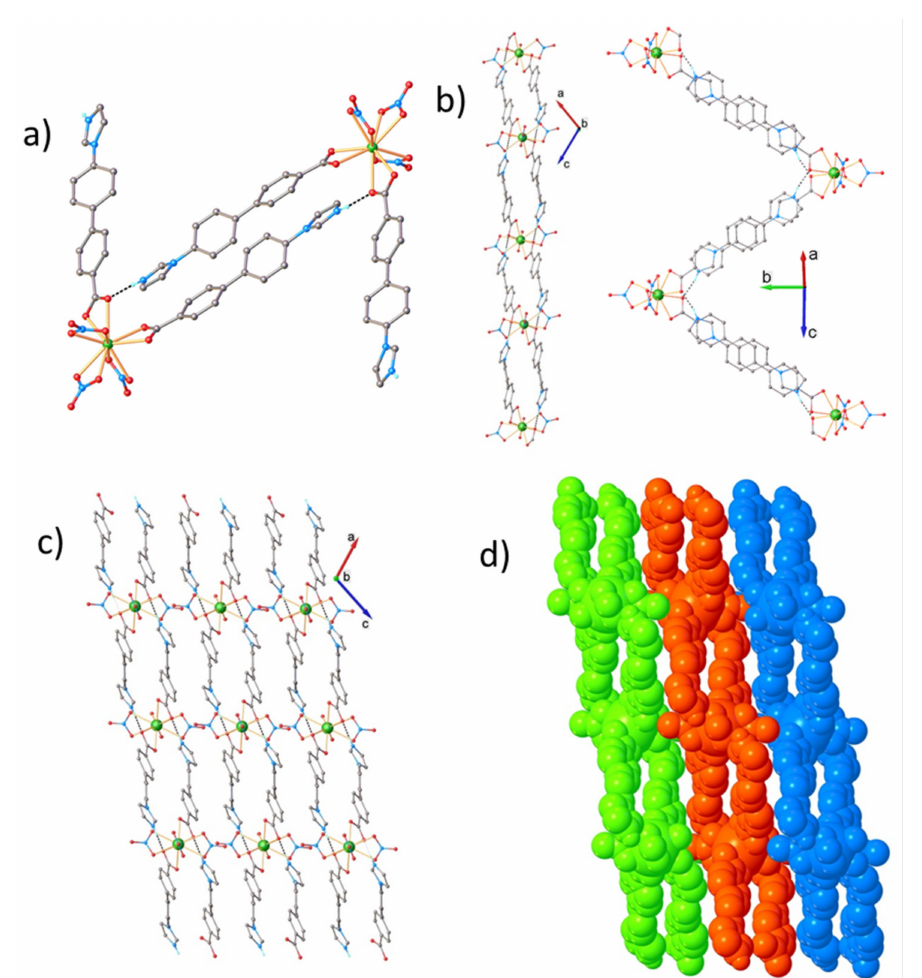
Figure 7. ( a ) The interaction of neutral [Eu(HL) 2 (NO 3 ) 3 ] complexes through N-H · · · O hydrogen bonds; ( b ) A view of zig-zag double chain along 010 and 101 directions; ( c ) Partial crystal packing viewed along b axis; ( d ) space filling representation showing the packing of 2D layers. Non-relevant H-atoms are omitted. H bond parameters: N2-H · · · O1 [N2-H 0.86 Å, H · · · O1 1.89 Å, N2 · · · O1( x − 0.5, − y , 0.5 + z ) 2.737(4)Å, ∠ N2HO1 167.8 ◦